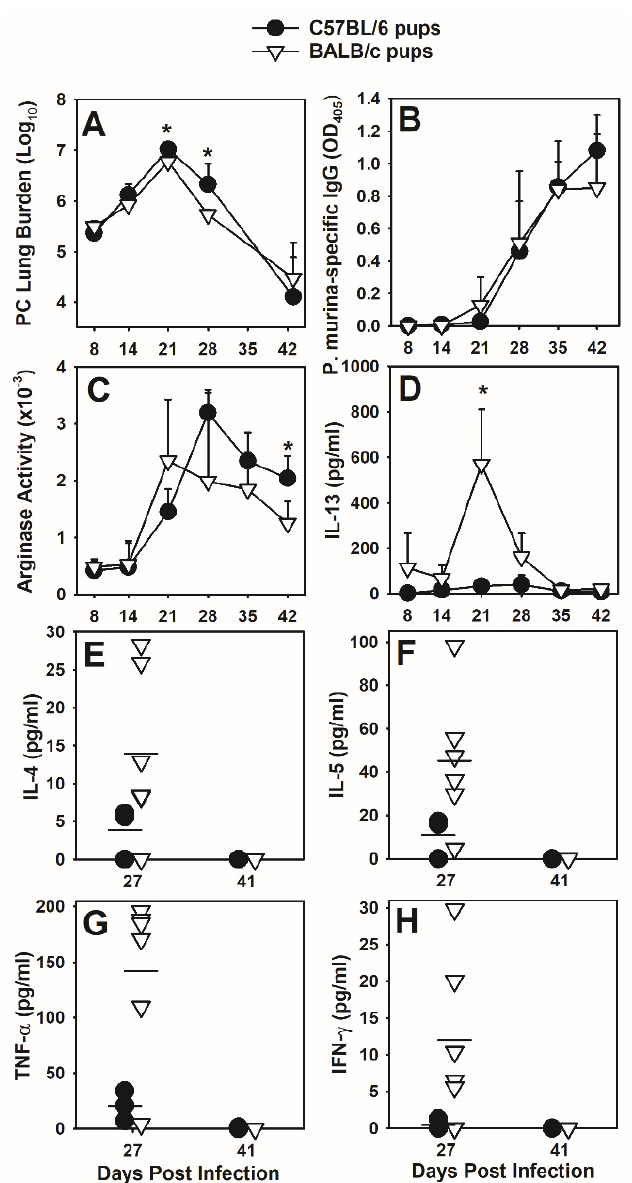
Figure A2. Strain background does not significantly alter clearance kinetics of P. murina in neonatal mice. Two-day-old BALB/c and C57BL/6 pups were infected with P. murina. At indicated days post infection, serum, BALF, and lung lobes were collected from 5–7 mice per group. ( A ) P. murina lung burden was determined microscopically. ( B ) Serum P. murina -specific IgG was determined by ELISA. ( C ) Arginase activity was determined from lung digest lysates as described in materials and methods. ( D ) IL-13 within the BALF was determined by ELISA. ( E – H ) IL-4, IL-5, TNF, and IFN γ concentration in the BALF were determined by Cytokine Bead Array and are shown as data from individual mice, horizontal line is the mean. * p ≤ 0.05, comparing P. murina infected BALB/c neonates to P. murina infected C57BL/6